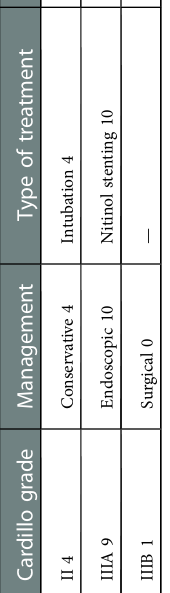
Surgery is recommended for highly symptomatic patients with large level IIIA, especially in case of ineffective mechanical ventilation, or level IIIB lacerations, mainly when involving vascular structures or esophagus, as well as for level IV tears, or any lesion occurring with mediastinitis (22, 35, 38). Most authors agree that fi t patients with rapidly worsening clinical conditions, despite previous conservative or endoscopic treatment, should undergo surgery, preferably within 48 – 72 h from the original event, to mitigate morbidity and mortality rates (2, 35, 50). Different surgical approaches are described in literature (2, 12): open, video- assisted thoracoscopy surgery (VATS), and endotracheal. The decision to perform one rather than others approach relies on the site and extent of injury, the emergency or elective setting, the experience of the center. Open techniques consist of posterolateral right thoracotomy (28), which was traditionally the approach of choice for emergency procedures and for middle or lower thirds tracheal injuries, and cervicotomy, as introduced by Angelillo- Mackinlay (51) in case of upper third lesions, possibly associated with sternal split if middle third is involved. VATS techniques include right thoracoscopy, as well as video-assisted transcervical- transtracheal approach, which was proposed by da Silva Costa and colleagues (36) introducing an endoscopic needle holder and a 0-degree camera though the tracheal incision. Either in open or T